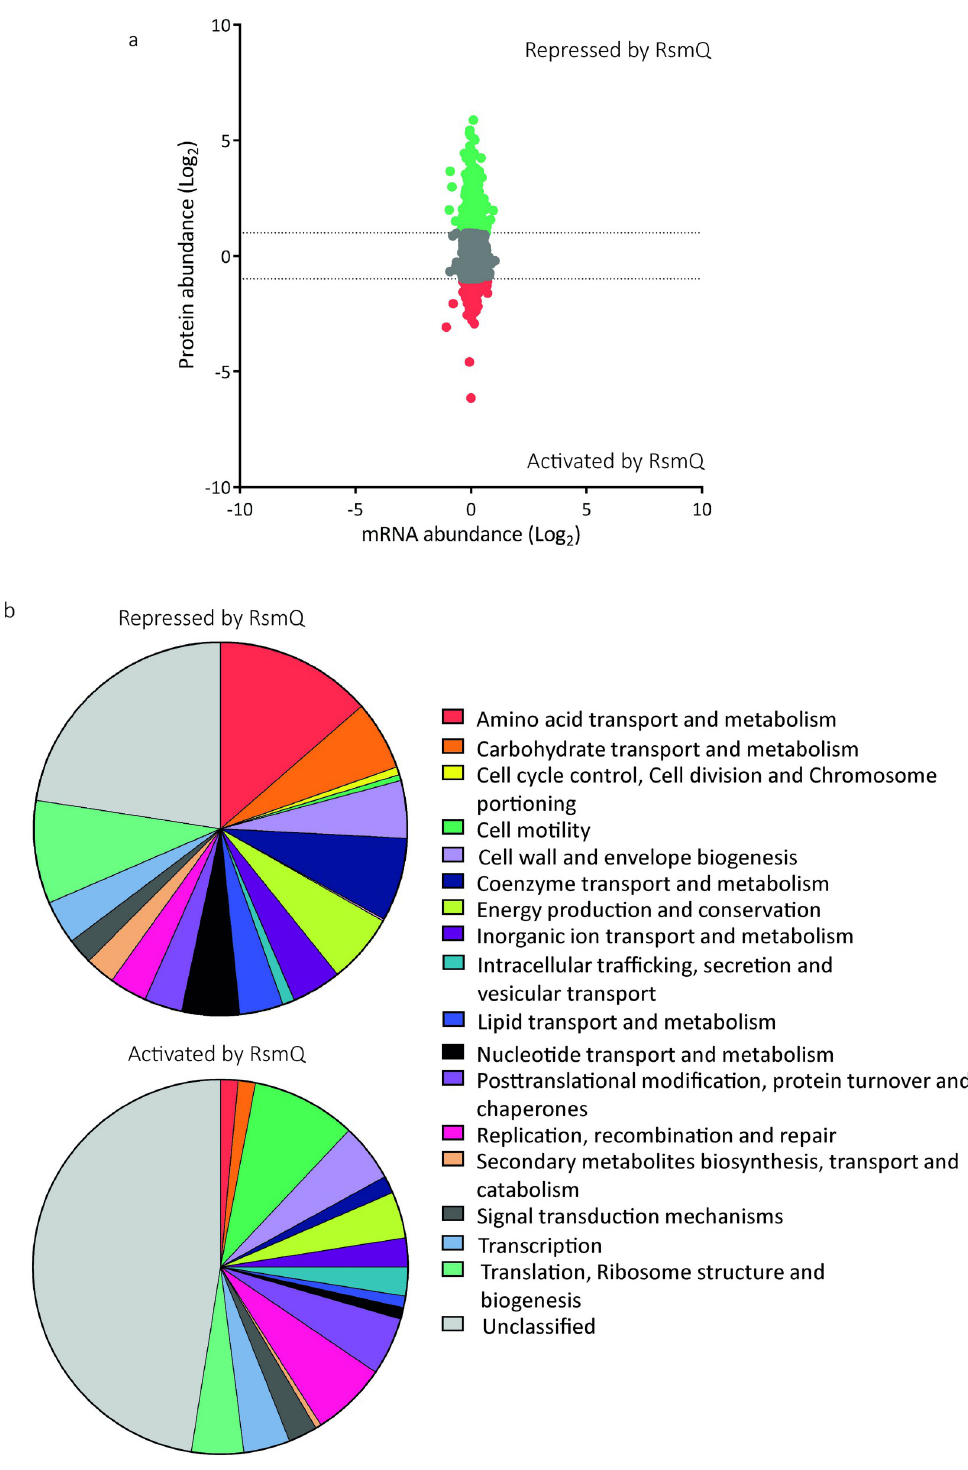
Fig 3. The loss of RsmQ causes widescale proteomic changes. (a) Comparative scatter plot comparing log 2 -fold mRNA abundance changes from RNAseq ( n = 5) to protein abundance changes seen by TMT quantitative proteomics ( n = 3). (b) COG categories of proteins that showed a greater than log 2 -fold change when rsmQ is lost (Repressed by RsmQ = 581, Activated by RsmQ = 203). Data are available in S1 Table and S2 Data. This data is also publicly available in ArrayExpress (E-MTAB-11868) and ProteomeXchange (PXD033640).